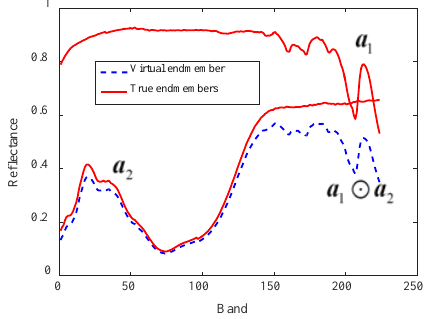
Figure 2. An example of virtual endmember’s spectral curve.